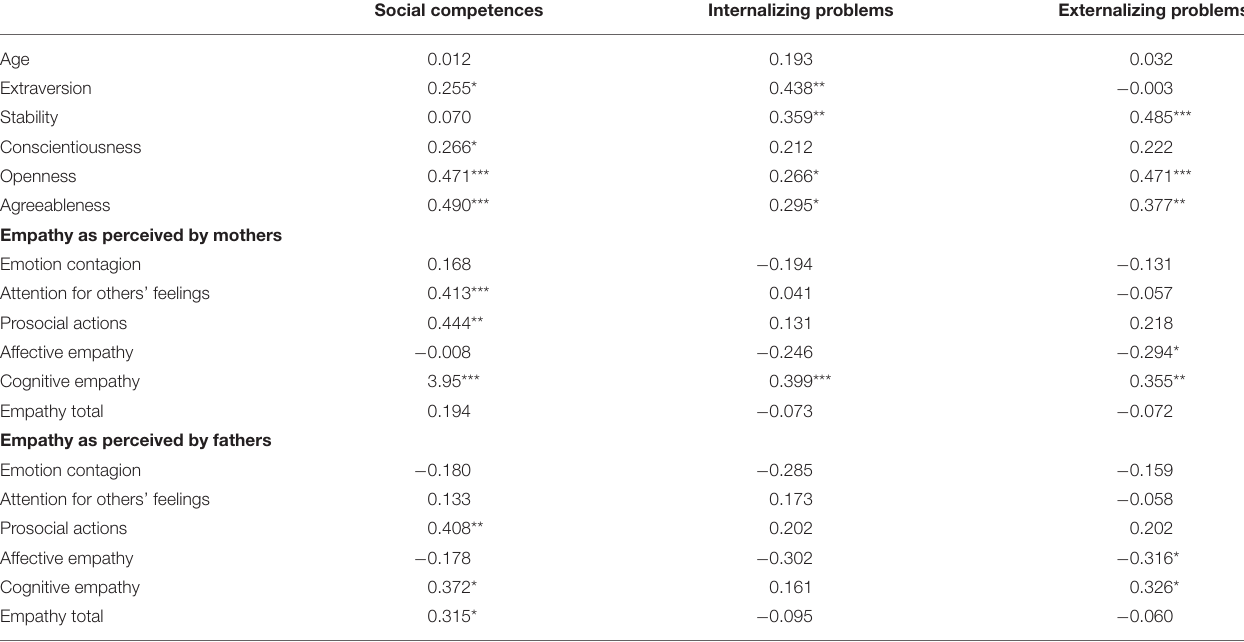
TABLE 6 | Spearman correlations between children’s individual characteristics, empathy and social skills, and behavioral